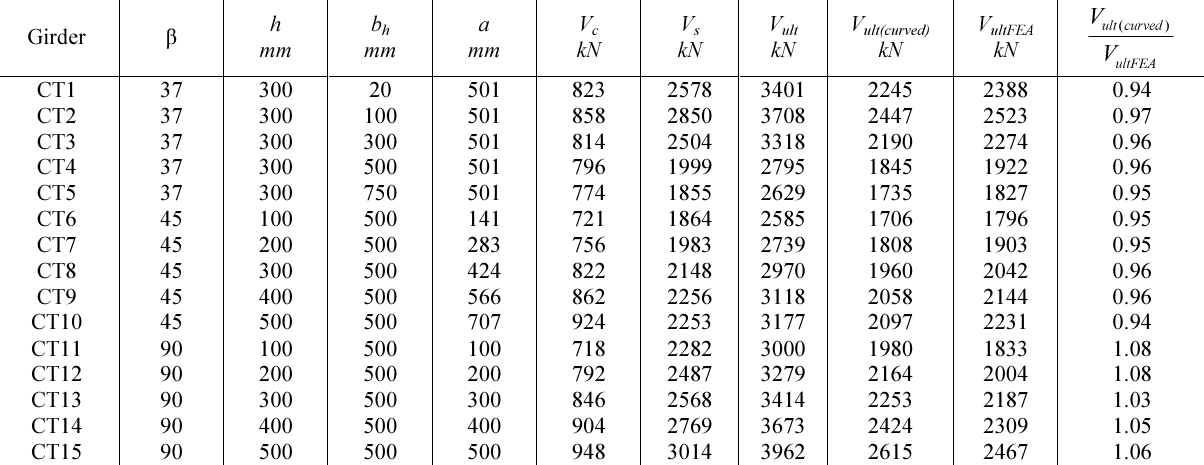
Table 3. Comparison of shear strength for girders with solid webs